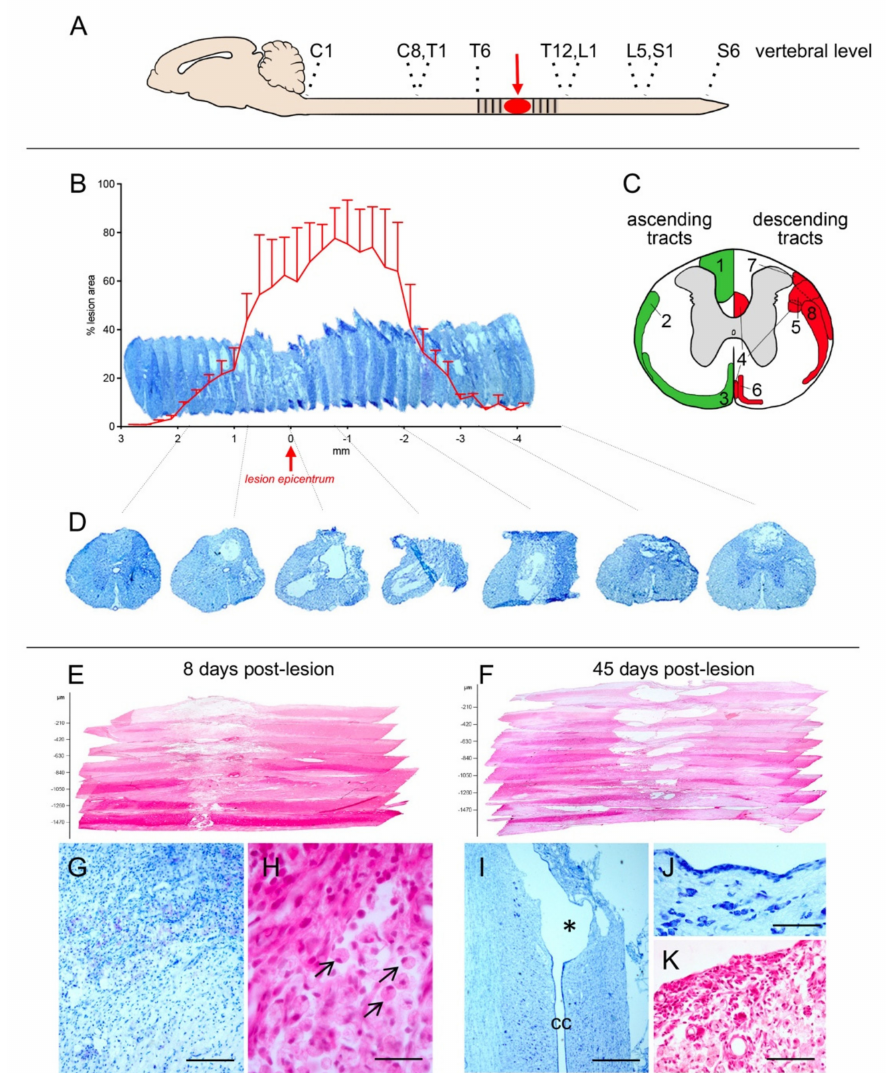
Figure 2. Anatomical analysis of the contusion model used in this study. ( A ) The epicenter of the impact (red) and the sampled area (dashed) are indicated. ( B ) 3D representation and quantitative evaluation of the lesion at 45 days post lesion (DPL), as performed in toluidine blue stained coronal sections. ( C ) Schematic representation of ascending (green) and descending (red) tracts in the Spinal Cord at T9. The numbers refer to the tracts, as follow: 1 dorsal column; 2 spinocerebellar; 3 spinothalamic; 4 corticospinal; 5 rubrospinal; 6 vestibulospinal; 7 reticulospinal; 8 raphespinal, ( D ) representative coronal sections all along the sampled rostro-caudal extension obtained from a sample animal. ( E , F ) 3D representation of the lesion d segments, as performed by HE staining on horizontal section at 8 ( E ) and 45 ( F ) DPL. ( G – K ) high power micrographs of the lesioned areas, illustrating the severe inflammatory cellular infiltrate ( G ) also enriched by gitter cells (marked by black arrows in ( H )) at 8 DPL; the cavitation communication with the central canal (marked by * in ( I )), respective ependymal-like lining layer ( J ), and persistence of the inflammatory cellular infiltrate ( K ) at 45 DPL. Bars: G 100 µ m; I 25 µ m; K 250 µ m; J, K 200 µ